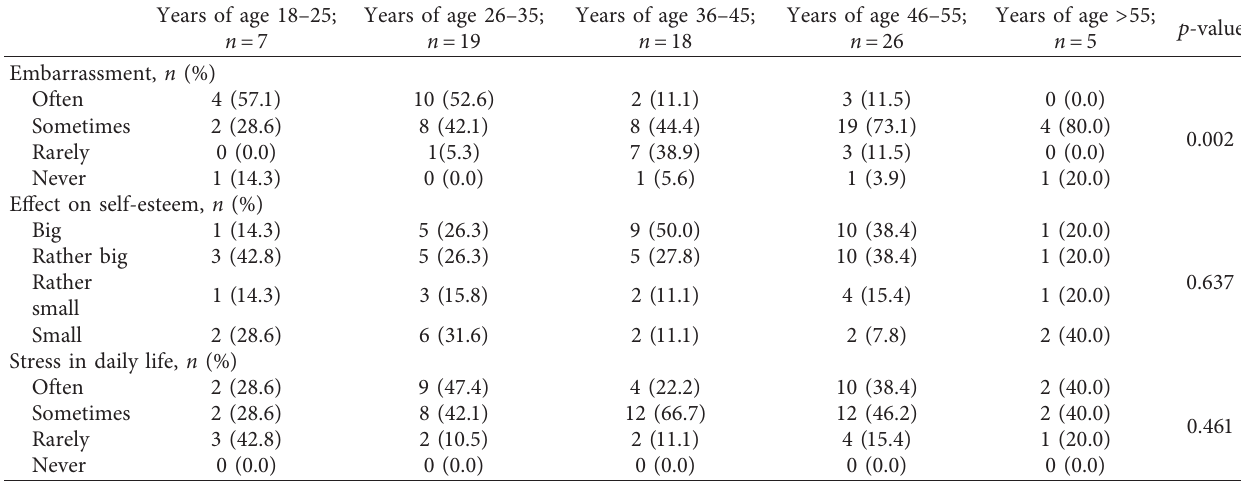
Table 1: Perceived symptoms due to androgenetic alopecia reported by the surveyed men. Years of age